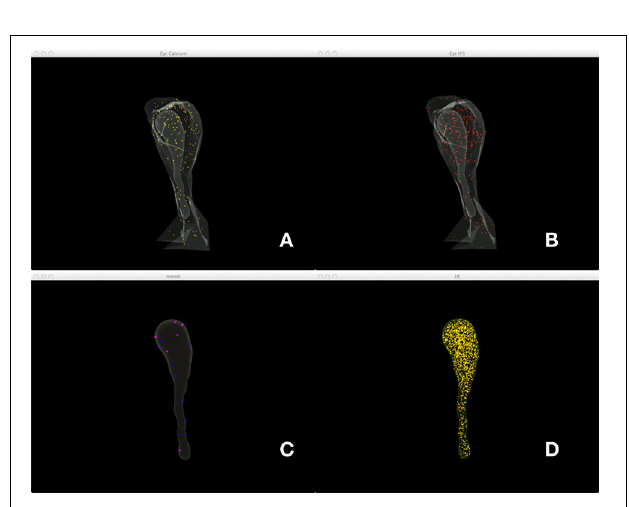
FIGURE 6 | A split view of the same simulation state as Figure 5. (A) Ca 2 + distribution in cytosol, (B) IP 3 in cytosol, (C) IP 3 receptors on the membrane with different states, (D) Ca 2 + in